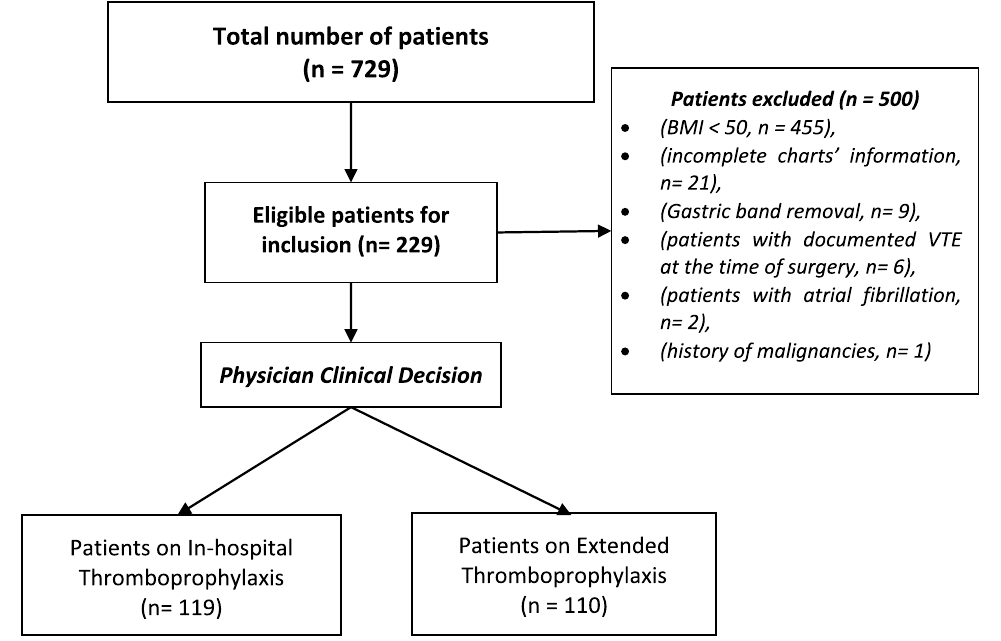
Fig. 1 Eligibility of patients for